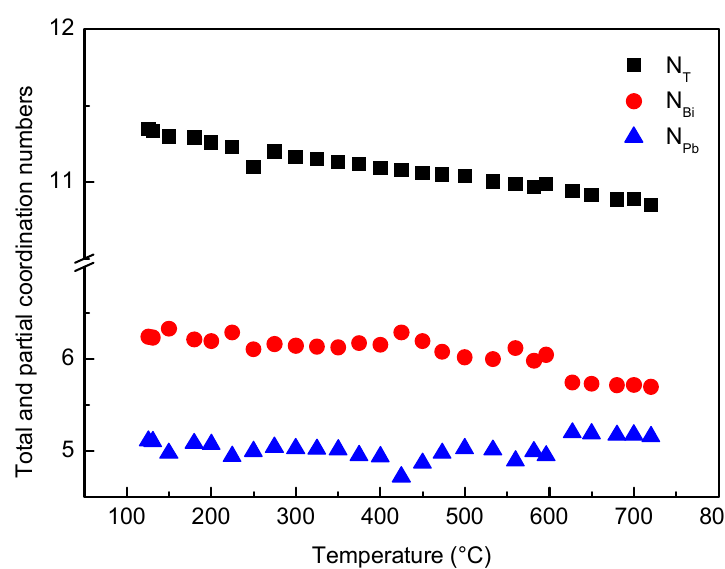
Figure 9. Total (N T ) and partial coordination numbers of Bi (N Bi ) and Pb (N Pb ) vs. temperature.